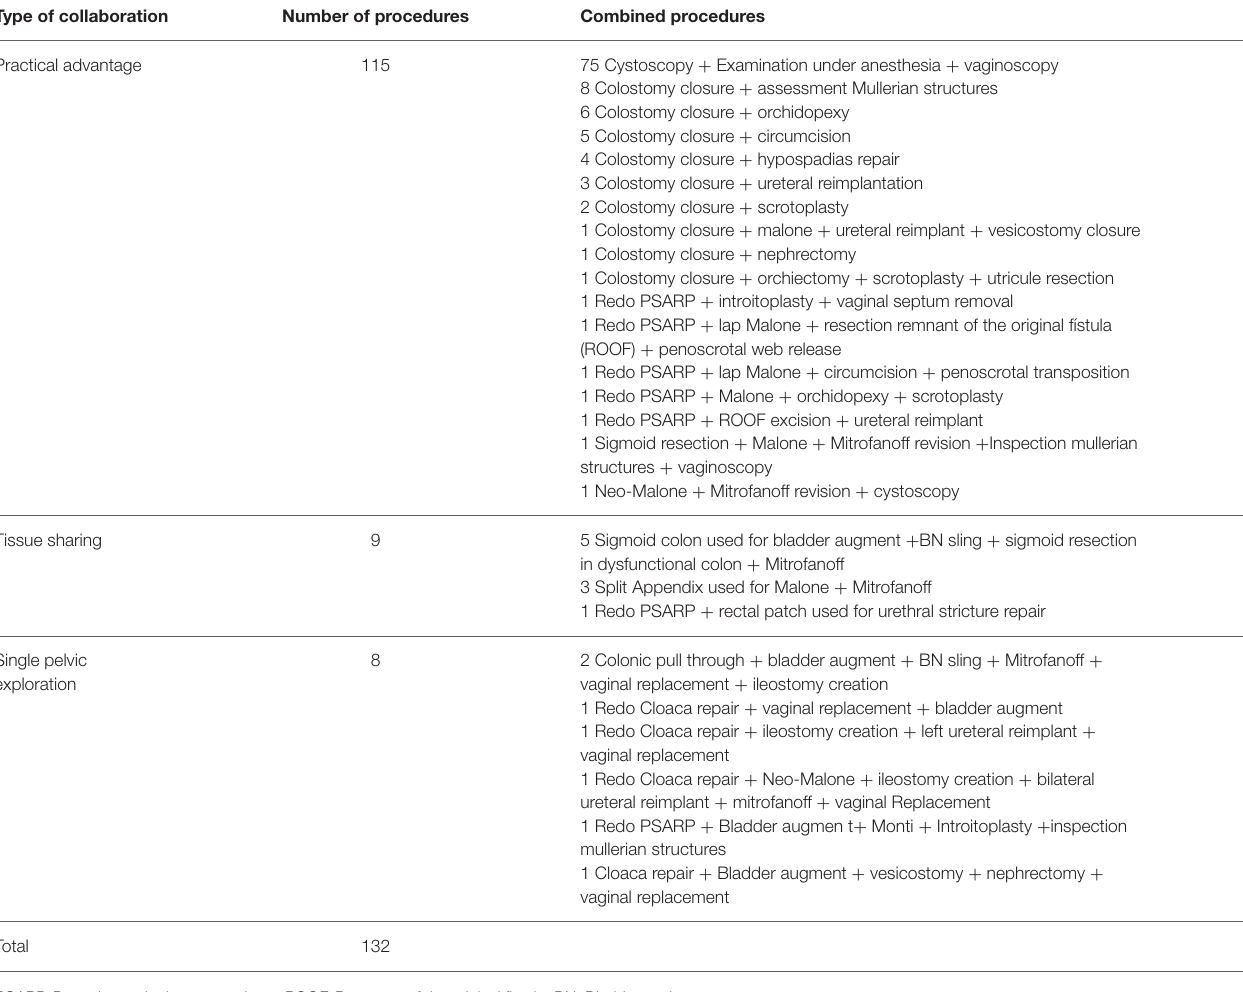
TABLE 2 | Description of the combined porcedures and reason for combined surgery. Type of collaboration Number of procedures Combined procedures Practical advantage